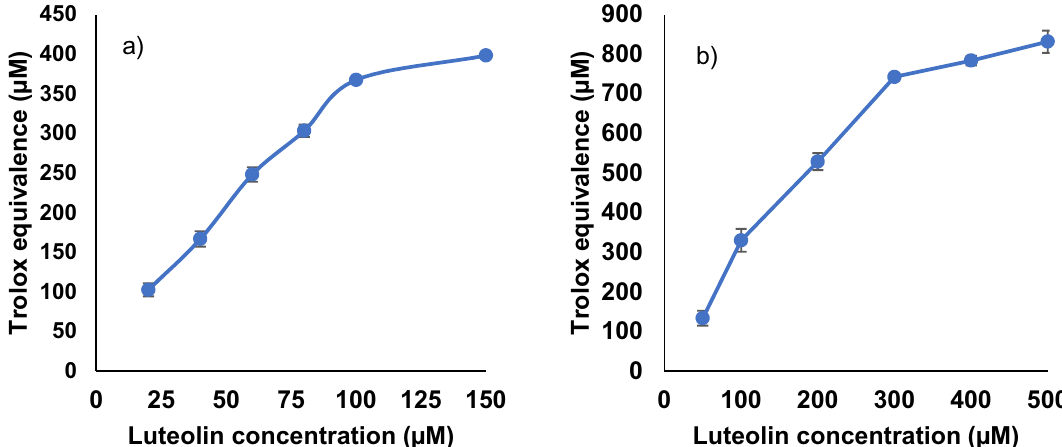
Figure 3. The Trolox equivalence (TE) of luteolin at various concentrations against ( a ) ABTS radical cation; and ( b ) against DPPH